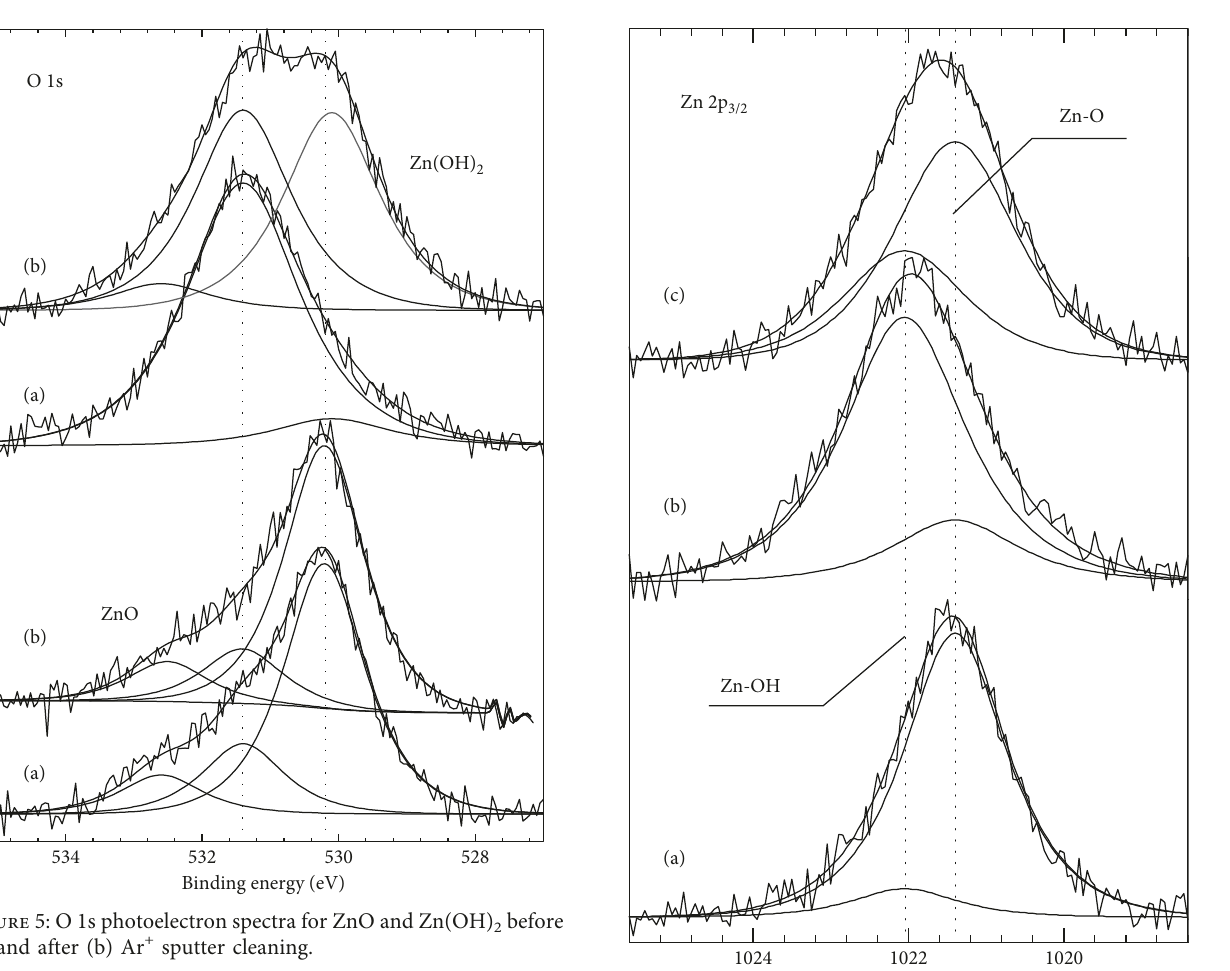
2 before Figure 6: Zn 2p 3/2 photoelectron spectra for ZnO (a) and Zn(OH) 2 (b) in the as-received form and for Zn(OH) 2 after Ar + sputter cleaning